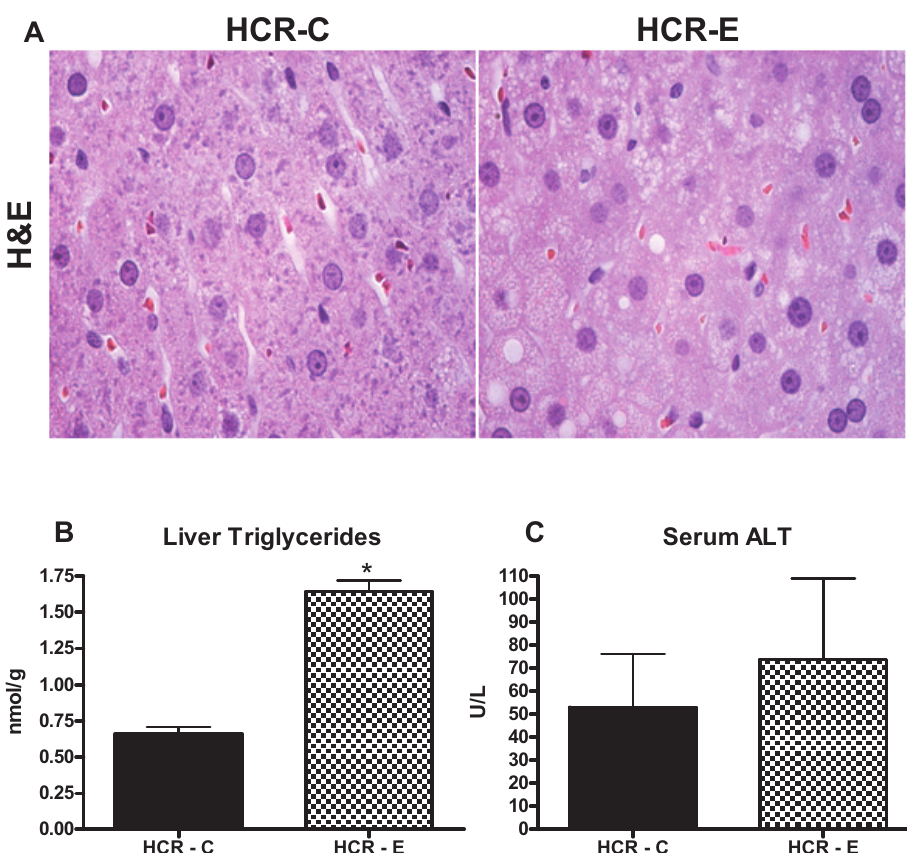
Figure 1. Effects of ethanol consumption on liver histology ( A ); liver TG accumulation ( B ); and serum ALT levels ( C ). ( A ) Representative H & E images; significant macro- and micro-vesicular lipid vacuolization were noted in HCR-E group (right panel). No inflammatory cells, hepatocyte ballooning or Mallory-Weiss bodies were noted; ( B ) Liver TG accumulation was significantly increased in the HCR-E animals; ( C ) Serum ALT levels were not different between the groups. Values (means ± SE) with * are significantly different ( p < 0.05); n =